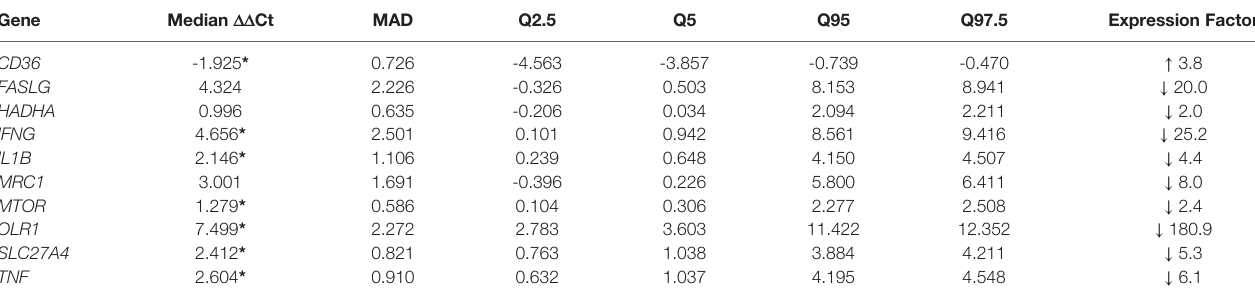
TABLE 5 | Differential gene expression levels between MDSC in BALF and PB, with respect to expression levels in BALF. Gene Median DD